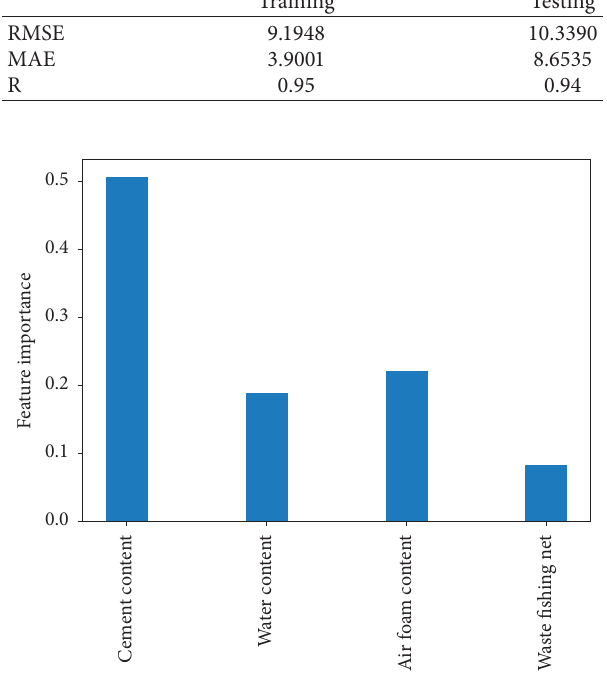
Figure 7: Importance of each input effect on unconfined com- pressive